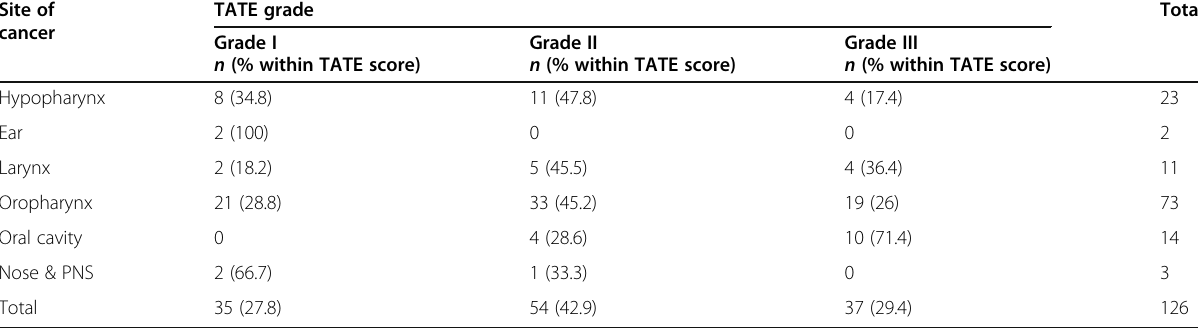
Table 3 Showing association between site of cancer and TATE score Site of cancer